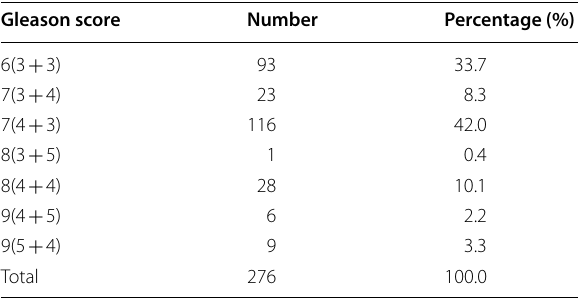
Table 2 Patient distribution by Gleason